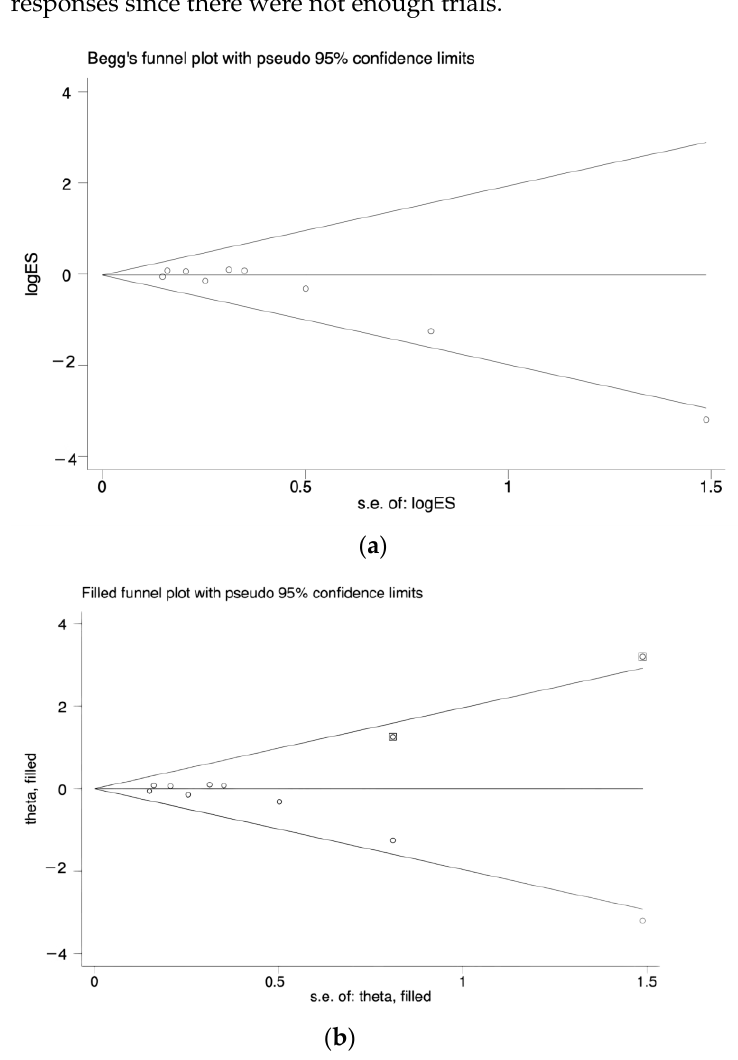
Figure 7. Publication bias analysis of the infection of COVID-19 between the BCG vaccination group and control: ( a ) The Funnel plot. ( b ) Trim and fill analysis.